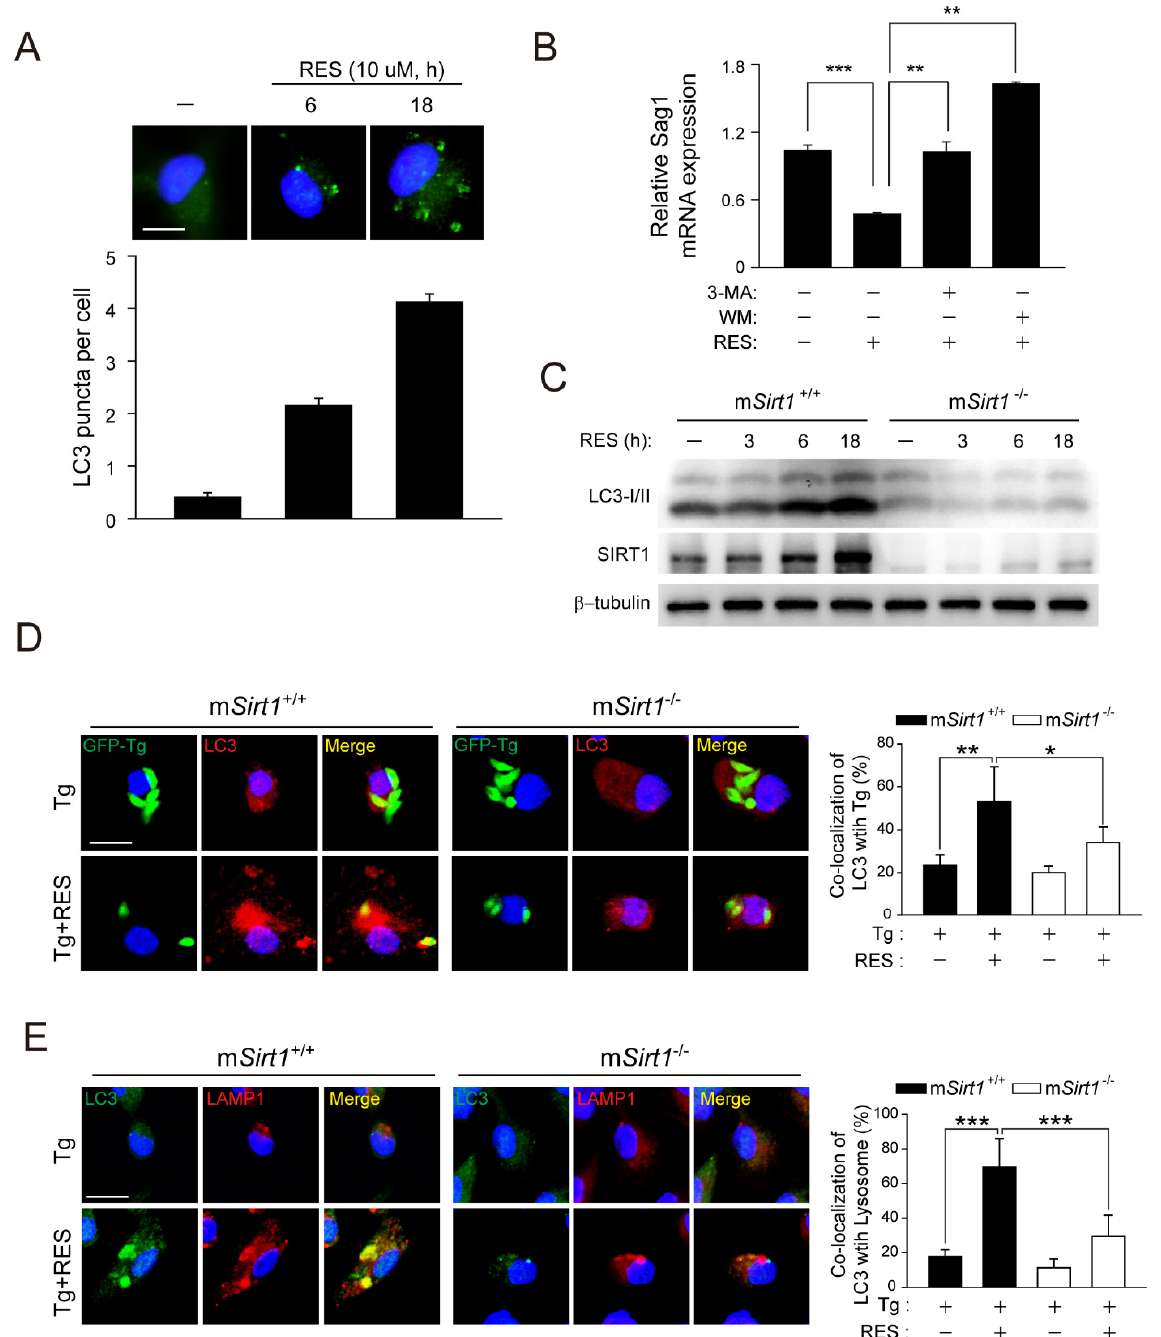
Figure 3. RES induces autophagy activation in a SIRT1-dependent manner. ( A ) BMDMs were stimulated with RES (10 µ M) for various times and subjected to immunofluorescence microscopy for analysing LC3 puncta formation (top). Quantification of LC3 punctate foci per cell (bottom). Each experiment included a minimum of 100 cells scored in 5 random fields. Scale bar = 10 µ m. ( B ) BMDMs were pre-treated with 3-MA (10 µ M, 2 h) or WM (100 nM, 2 h) and further incubated with RES for 18 h. The mRNA expression of the Sag1 gene was evaluated by real-time qPCR analysis. ( C ) BMDMs from m Sirt1 +/+ and m Sirt1 − / − mice were stimulated with RES for the indicated time periods and subjected to immunoblot analysis of LC3 and β -tubulin. ( D , E ) BMDMs from m Sirt1 +/+ and m Sirt1 − / − mice were infected with a GFP-conjugated RH strain (for D ) or a T. gondii RH strain (for E ) for 2 h, followed by further treatment of RES (10 µ M) for 18 h. ( D ) Cells were immunostained with an anti-LC3 antibody (Alexa Fluor 594-conjugated goat anti-rabbit IgG, red)